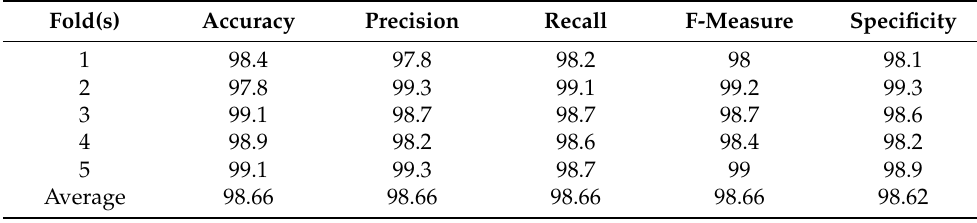
Table 4. Performance analysis of PCNN model for dataset_2.